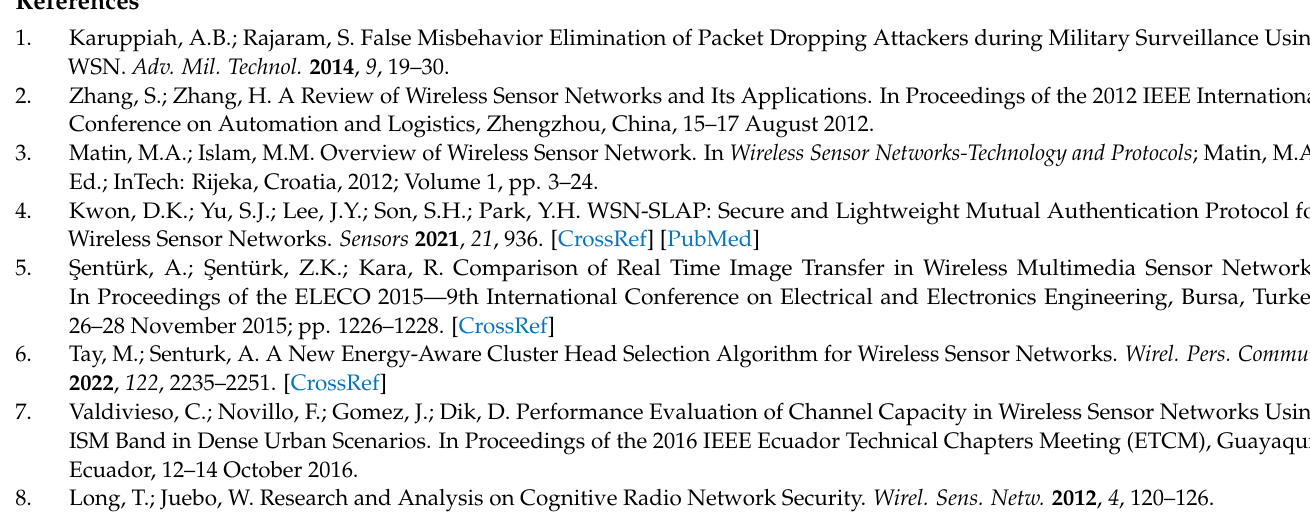
Figure A5. Role of the session and environment.